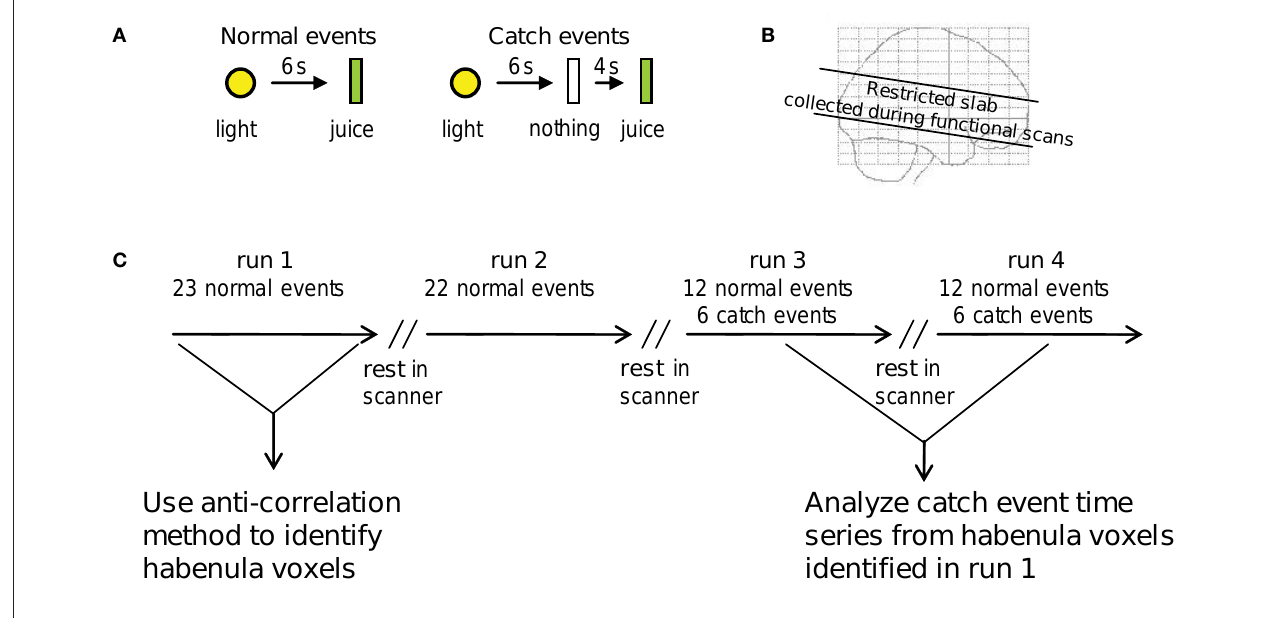
FIguRe  | experimental design. (A) Two basic behavioral probes were used – (1) normal events where a 1-s duration yellow light predicted the oral delivery of fruit juice (0.8 ml) 6 s later (normal event), and (2) the same stimuli but with the juice delivery delayed by an additional 4 s (catch event). (B) Functional scans were restricted to a 4.4-cm slab aligned along the anterior commissure-posterior commissure line using isotropic voxels (2 × 2 × 2 mm; TE = 40 ms, TR = 2 s, flip angle = 90 ° ). (C) Four separate runs were carried out. 23 normal events in run 1,